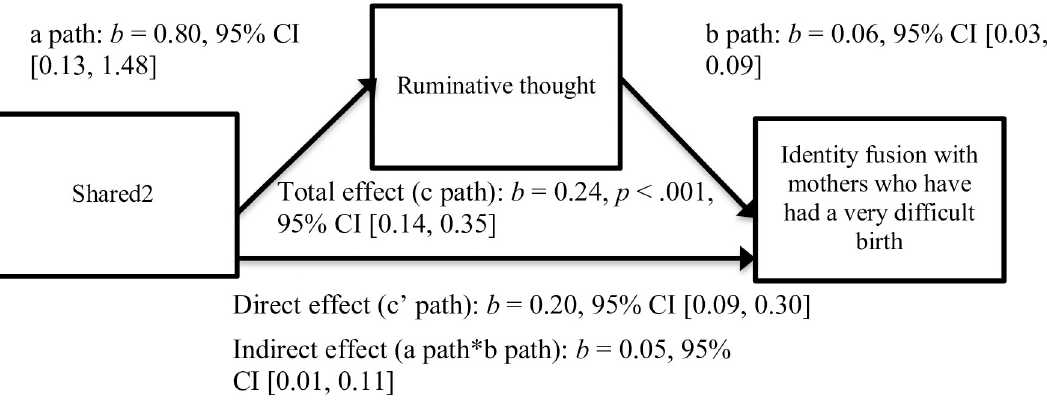
Fig 2. Mediation model of fusion with mothers who had a difficult birth via sharedness and ruminative